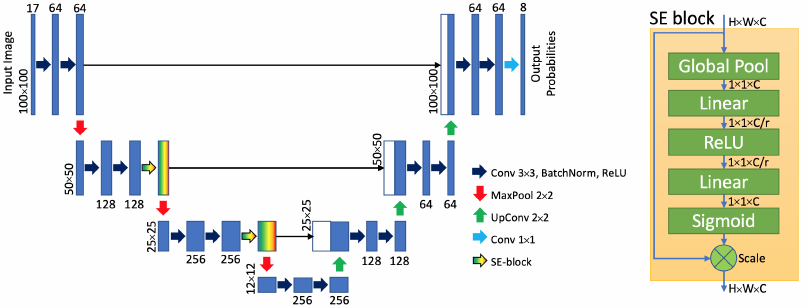
Figure 2. Architecture of U-Net with SE-blocks used for crop classification.